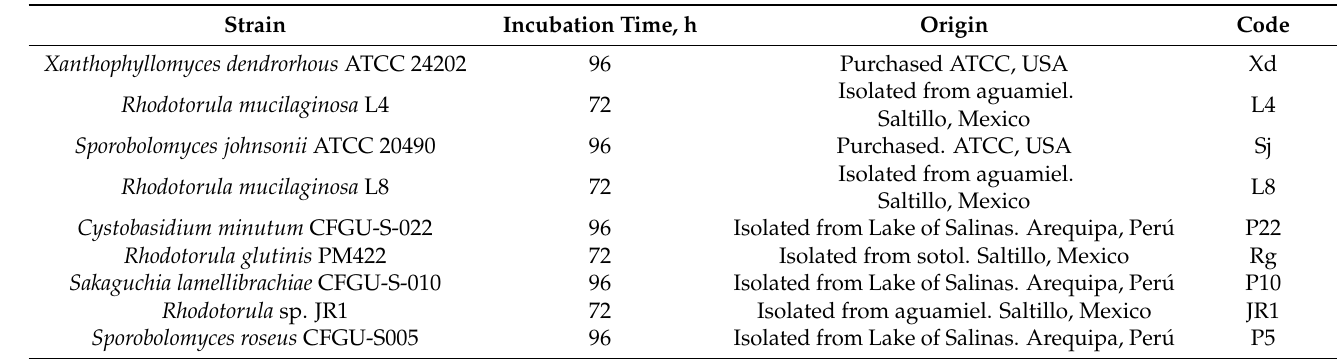
Table 1. Incubation time and origin of yeast strains used in screening experiments to simultaneously produce microbial oil and